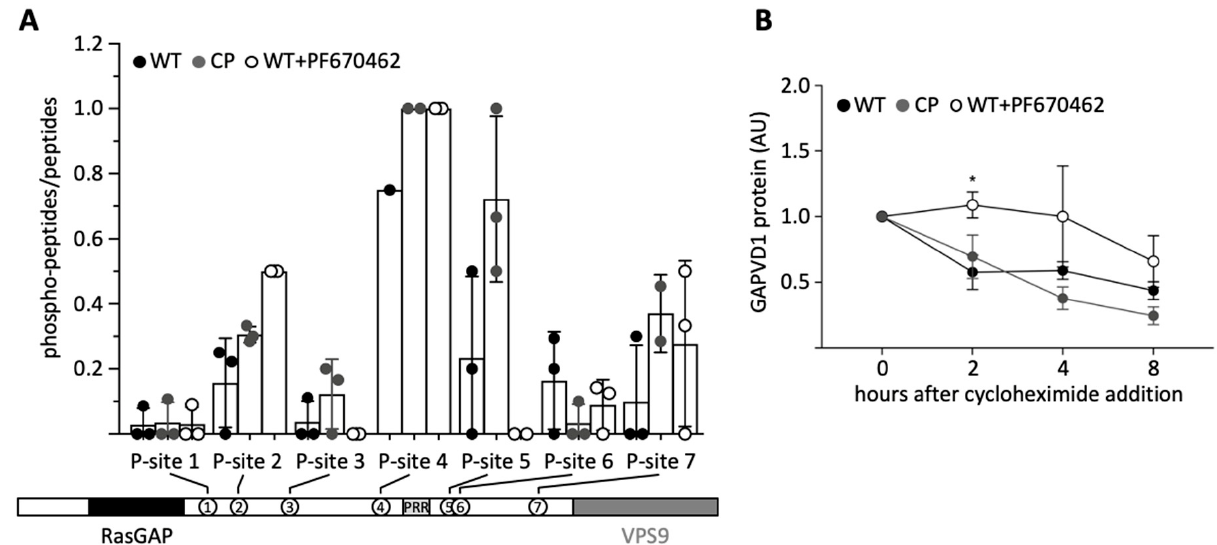
Figure 6. Phosphorylation regulates the speed of GAPVD1 degradation. ( A ) The ratio of phosphorylated to unphosphorylated peptides in each sample is shown for all peptides that were identified in HT1080 wild type cells (black), CP cells (grey), or wild type cells pre-treated with 20 µM PF670462 for 18 h (white). Circles show single data points; error bars show standard deviations. Samples in which neither a phosphorylated nor an unphosphorylated peptide was detected for a specific phosphorylation site (P-site) were omitted from the dataset. The locations of P-sites relative to the RasGAP and VPS9 domains and a proline rich region (PRR) in GAPVD1 are shown underneath [26]; ( B ) Degradation kinetics of GAPVD1 after treatment with 50 µM cycloheximide in HT1080 wild type cells (black), CP cells (grey) or wild type cells pre-treated with 20 µM PF670462 for 18h (white). GAPVD1 protein levels were normalized to Calnexin, and t = 0 values were set to 1. Lines connect replicate means (n = 4); error bars show standard errors of mean. * p < 0.05 ( t -test).